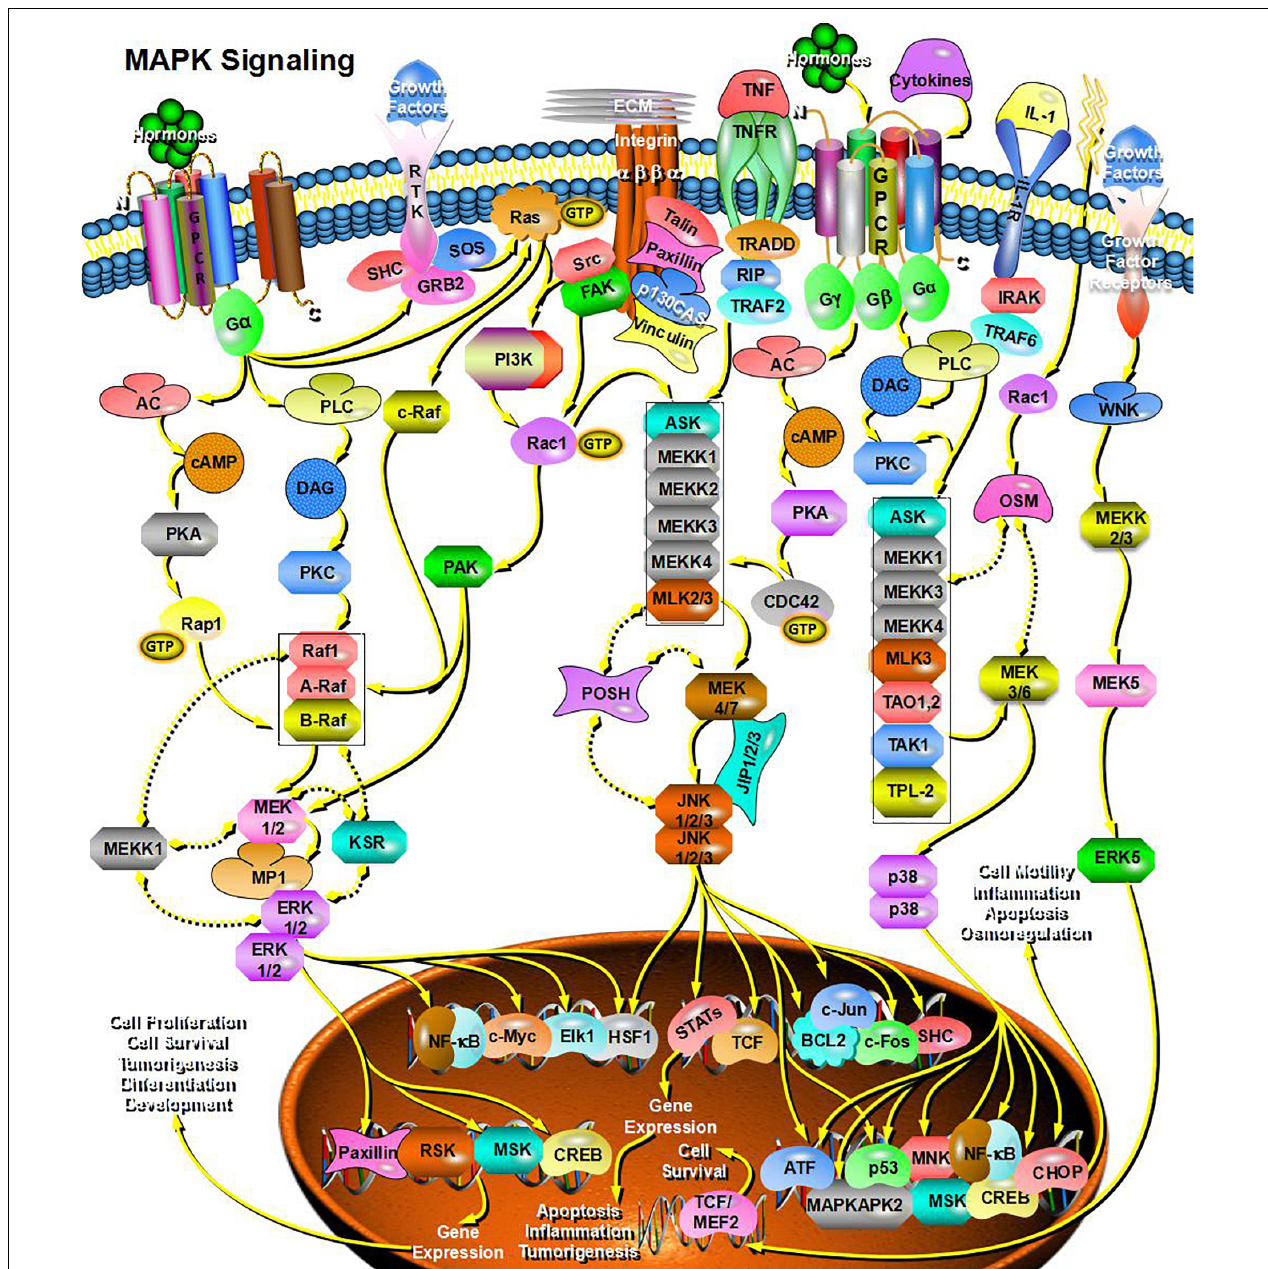
FIGURE 3 | miRNA-28-3p promotes cell proliferation through the MAPK signaling pathway and participates in the regulation of diabetes.